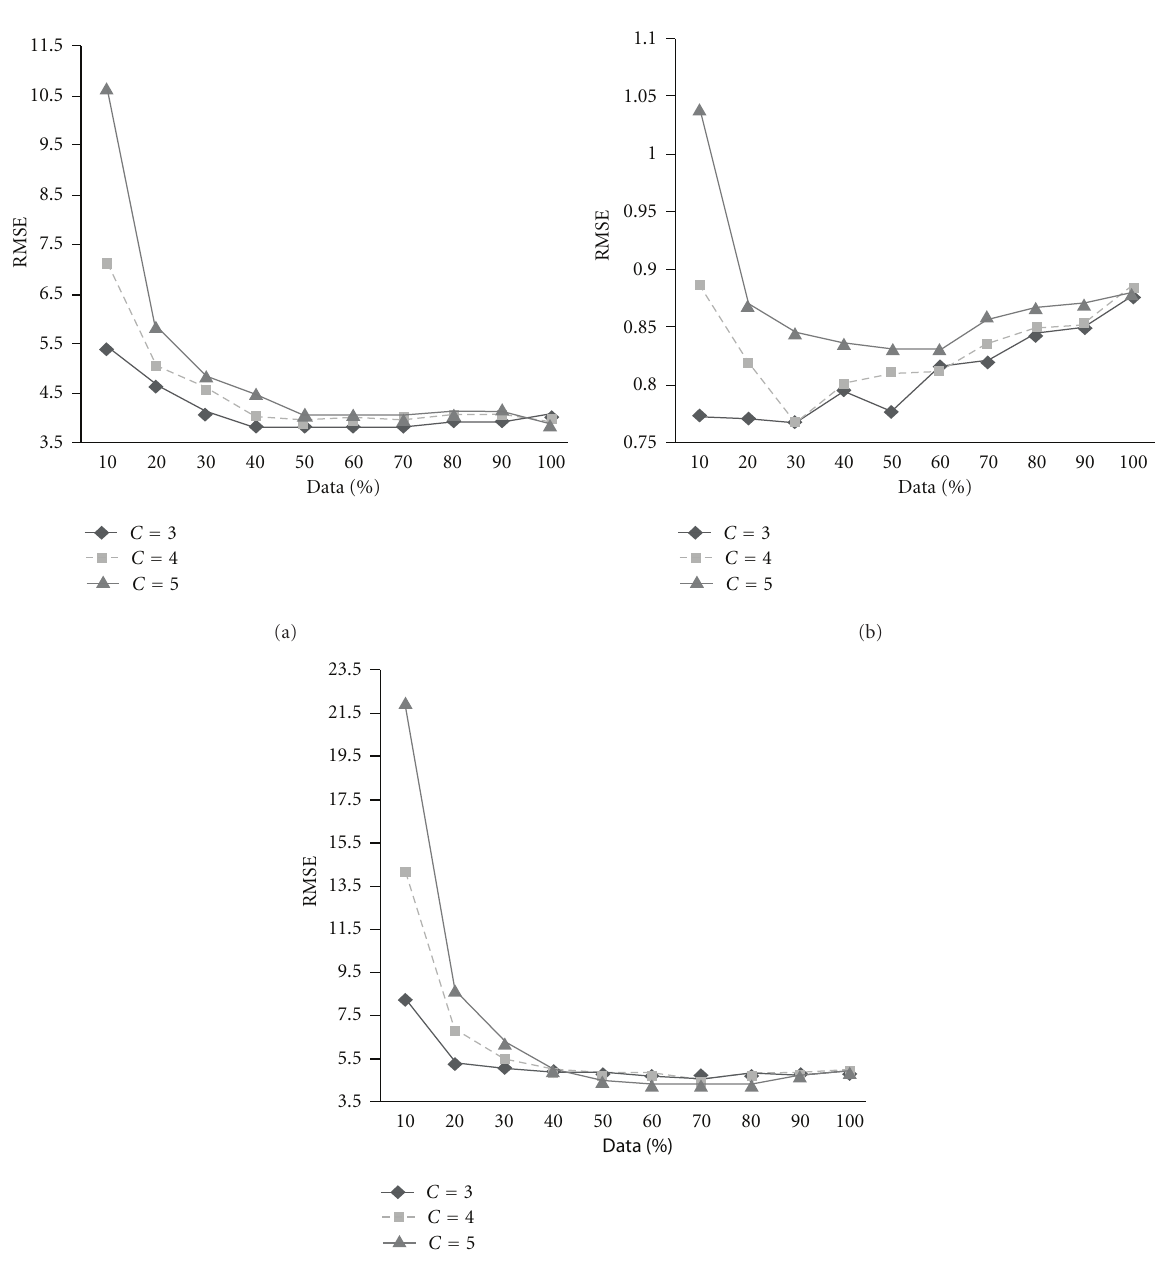
Figure 9: The values of RMSE versus the percentage of data for selected number clusters: (a) housing data, (b) PM10 data, and (c) body fat